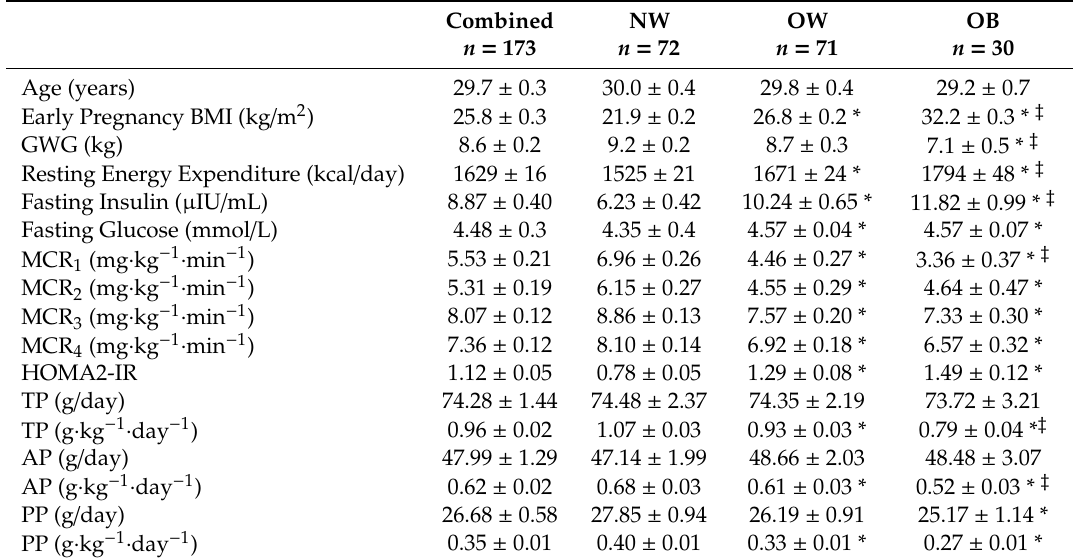
Table 1. Descriptive